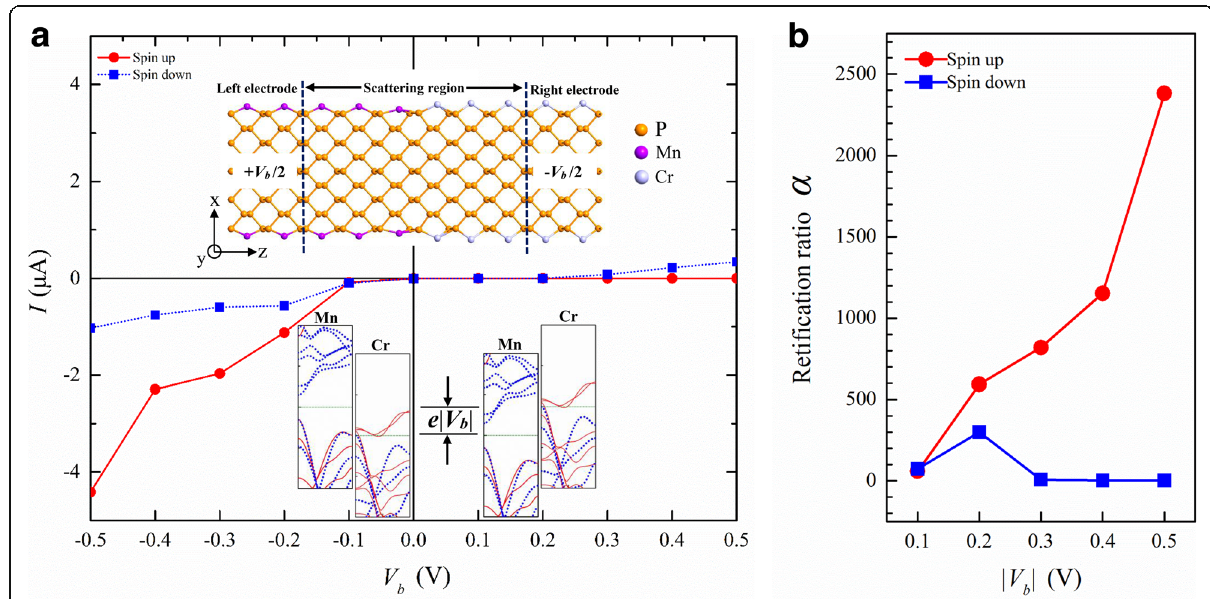
Fig. 7 a The spin-dependent I-V characteristic of a Mn/Cr-9-APNR heterojunction. The geometry of the two-probe system is shown in the upper inset. The lower insets scheme the alignments of electrode energy bands for negative and positive biases. b The corresponding rectification ratio α is plotted versus the bias